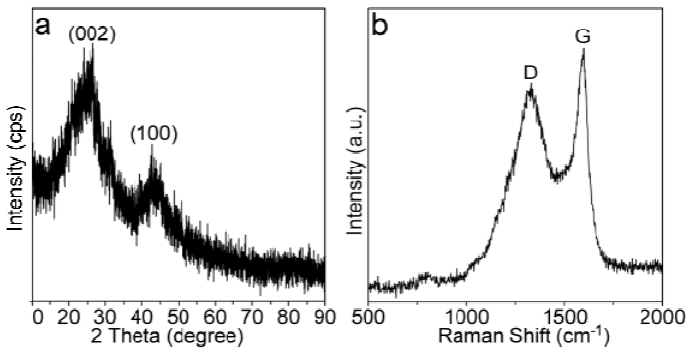
Figure 1. ( a ) X-ray diffraction (XRD) pattern and ( b ) Raman spectrum of the as-prepared moss-derived biomass porous carbon (MPC).